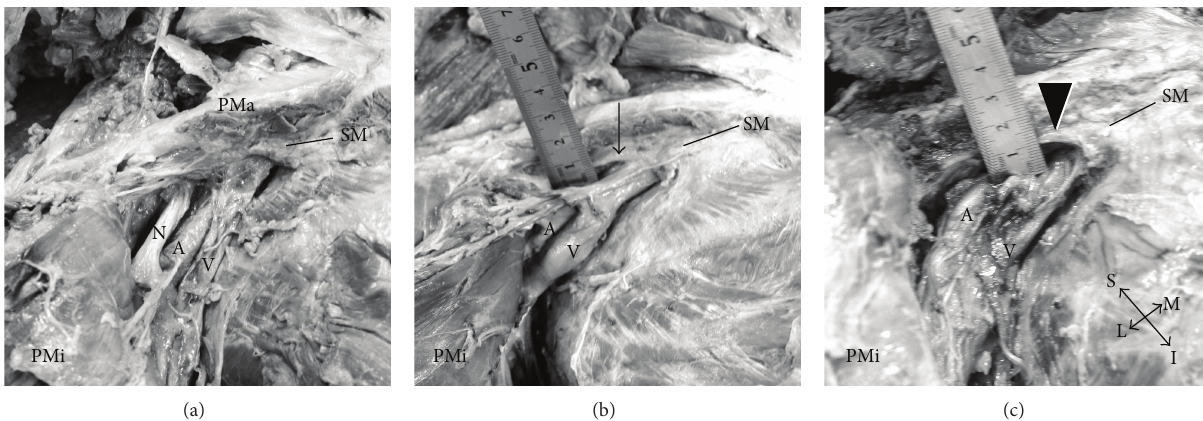
Figure 1: Anatomical relationship of the subclavian vein and the subclavian muscle. (a) Connected group. The subclavian vein (V) is tightly adherent to the subclavius muscle (SM) via the clavipectoral fascia. (b) Partly connected group. The lateral part of the subclavius muscle is not adherent to the subclavian vein (arrow). (c) Unconnected group. The subclavian vein is completely separate from the subclavius muscle (arrowhead), both laterally and medially. The space between the muscle and vein contains loose connective tissue composed of sparse fibers and adipocytes. PMa: pectoralis major (transected), PMi: pectoralis minor (turned